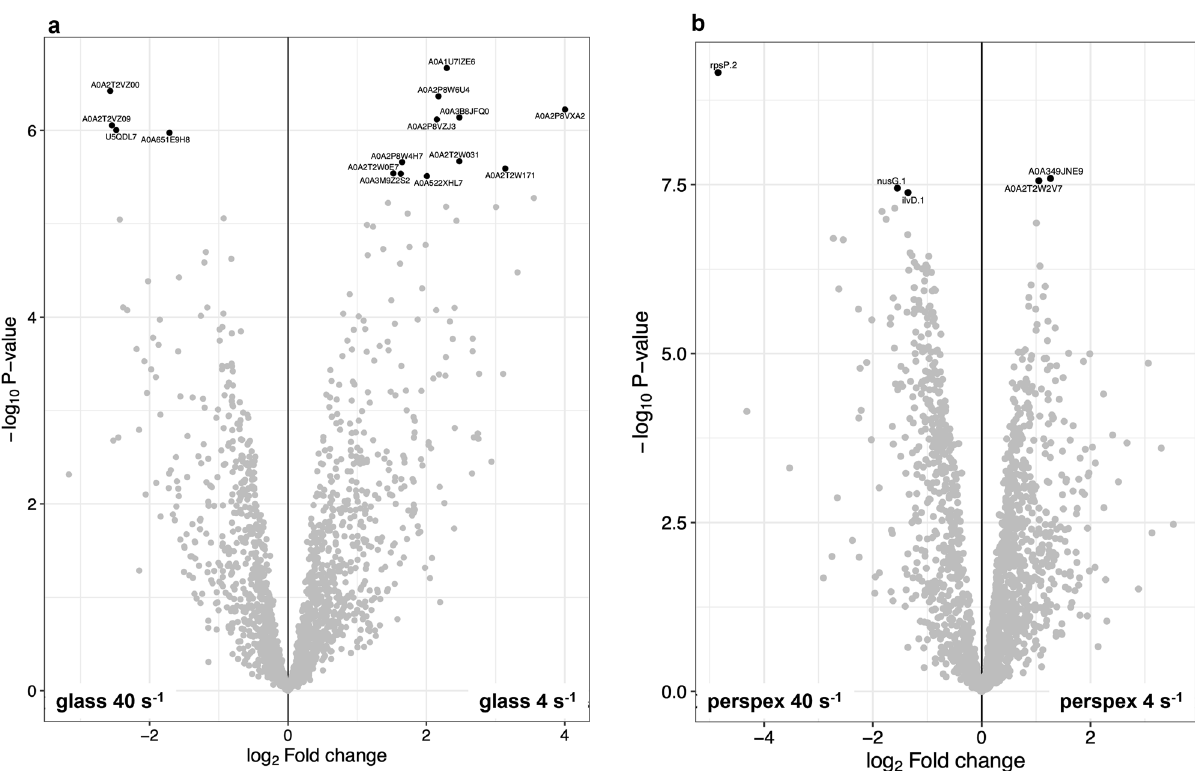
Fig. 6 Volcano plot of the differentially expressed proteins (DEPs) identi fi ed between comparisons of the same surface studied at different hydrodynamics conditions. The fi gure displays the DEPs (black dots) and their corresponding accession/gene names, as the resulting P values ( − log 10 ) in the y-axis, plotted against the fold changes (log 2 ) in the x-axis, obtained between the comparisons 4 s − 1 vs . 40 s − 1 on glass ( a ) and on perspex ( b